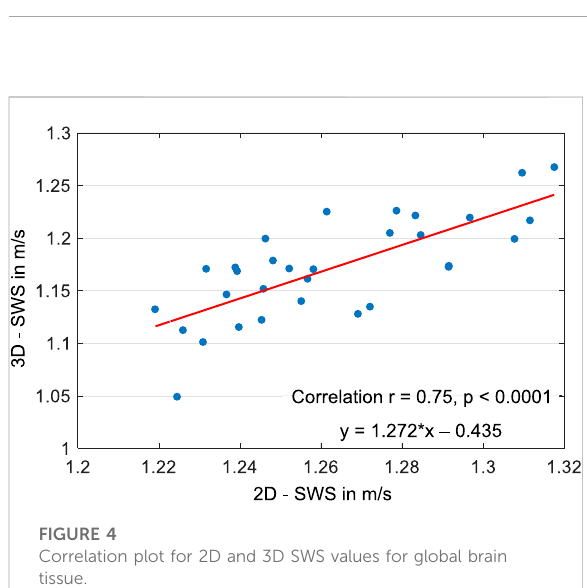
FIGURE 4 Correlation plot for 2D and 3D SWS values for global brain